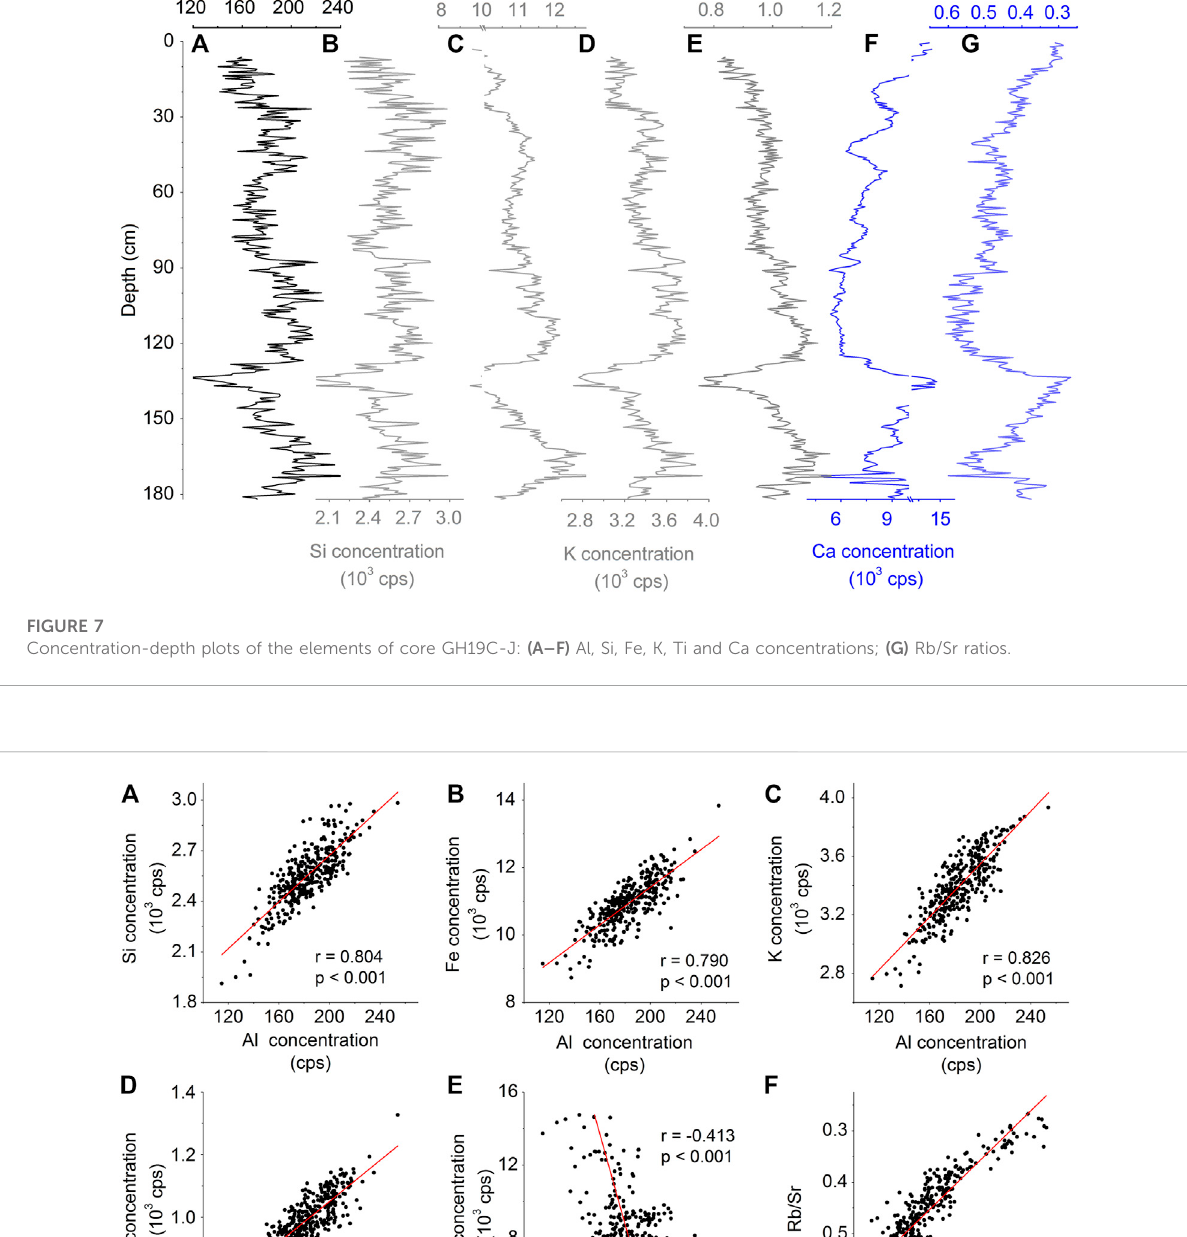
Frontiers in Earth